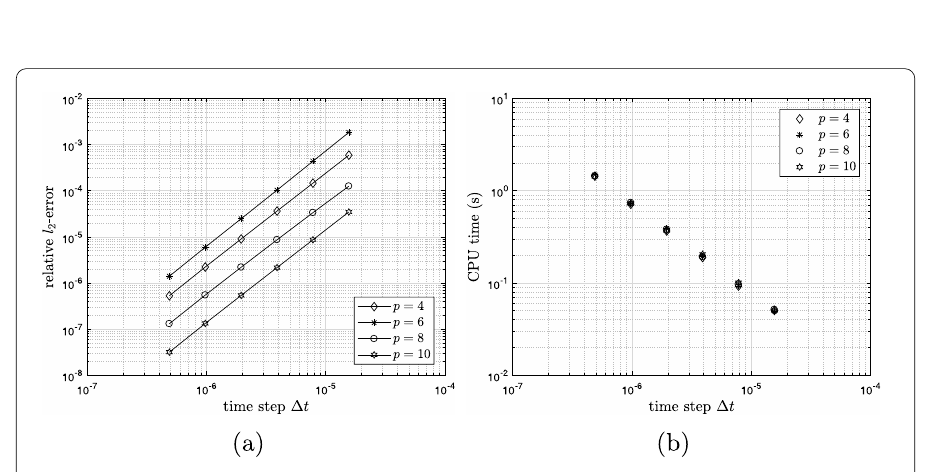
Figure 3 ( a ) Relative l 2 -errors of φ ( x , t f ) with different p for (cid:7) t = t f /2 12 , t f /2 11 , ... , t f /2 7 with (cid:4) = 0.02 and (cid:7) x = 1 . ( b ) CPU time versus time step with different 128